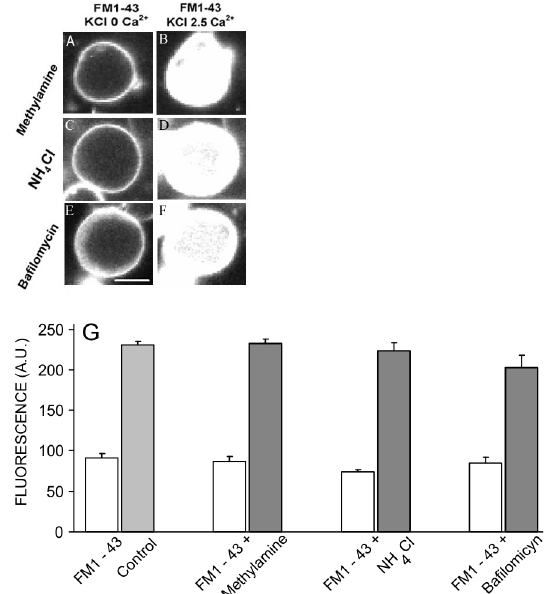
FIGURE 2 - Inhibition of synaptic vesicle filling did not influence exocytosis at the frog neuromuscular junction. Frog FIGURE 3 - Synaptic vesicle trafficking is not altered when neuromuscular junctions labeled with FM1-43 during stimulation vesicles exhibit deficits in acidification and filling at retinal with KCl 60 mм ( A and C ), KCl + NH Cl 30 mм ( E ), KCl + bipolar cells. Bipolar cell terminals incubated with methylamine 4 methylamine 10 м ( G ) and KCl + bafilomycin 1µм ( I ). FM1-43 10 mм ( A ), NH Cl 30 mм ( C ) and bafilomycin 500 nм ( E ) 4 destaining after 30 min of image acquisition due to photobleaching ( B ), stimulation with KCl 60 mм ( D ), KCl + NH Cl 30 mм ( F ), 4 KCl + Methylamine 10 м ( H ) or KCl + bafilomycin 1µM ( J ). Quantification of FM1-43 destaining due to photobleaching or stimulation with KCl, KCl + NH4Cl, KCl + methylamine and KCl + bafilomycin, respectively ( K ). Note that the rate of K+- induced exocytosis and FM1-43 destaining was not affected by agents which collapse the electrochemical gradient and reduce the quantal content. Error bars: ± SEM of 252 spots from 31 nerve terminals. Scale Bar for all images = 10 µm.